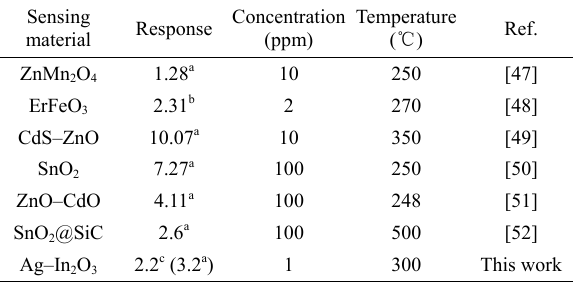
Performance comparison of isopropanol sensors based on metal